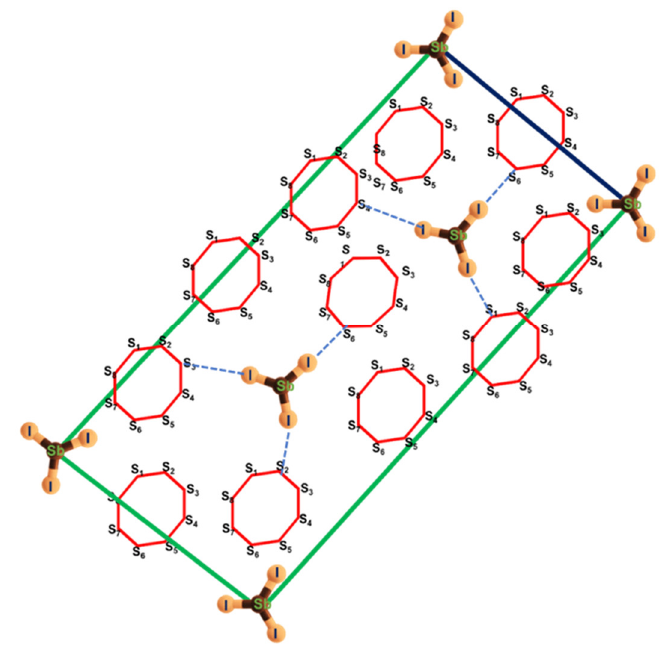
Figure 1. Schematic diagram of SbI 3 •3S 8 crystal structure.